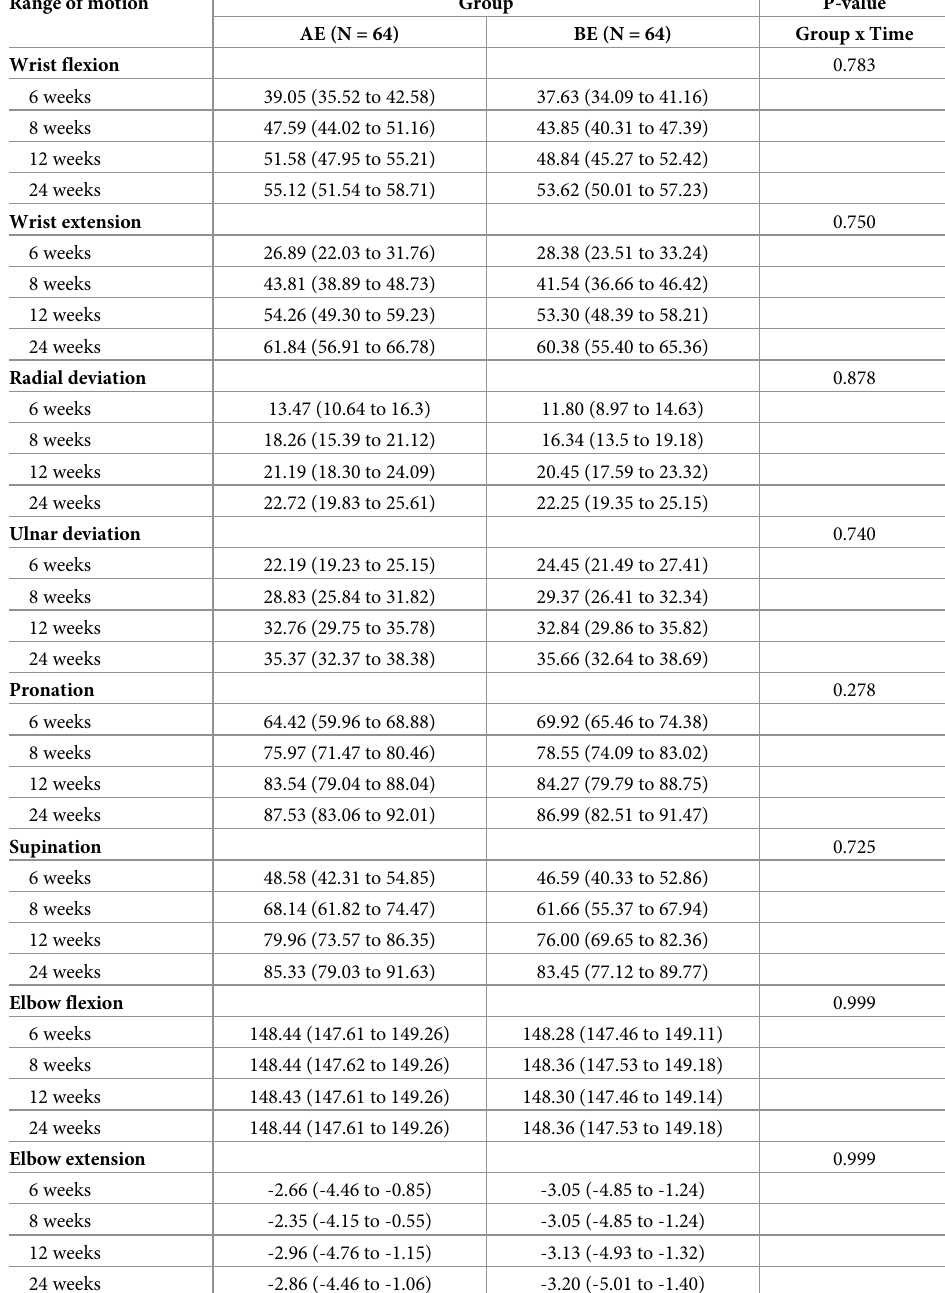
Table 6. Results of physical examination, show as mean